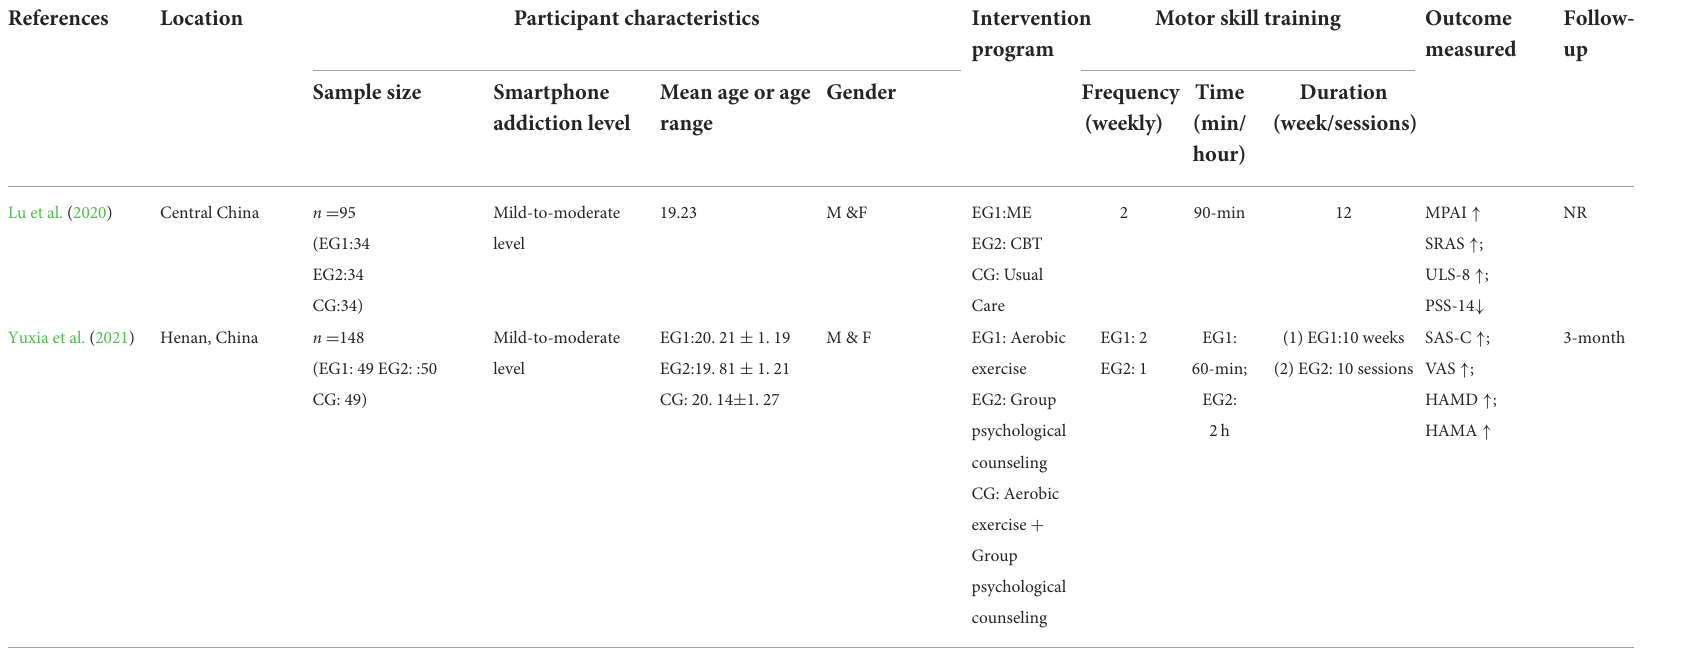
TABLE 4 Overview of combined intervention with smartphone